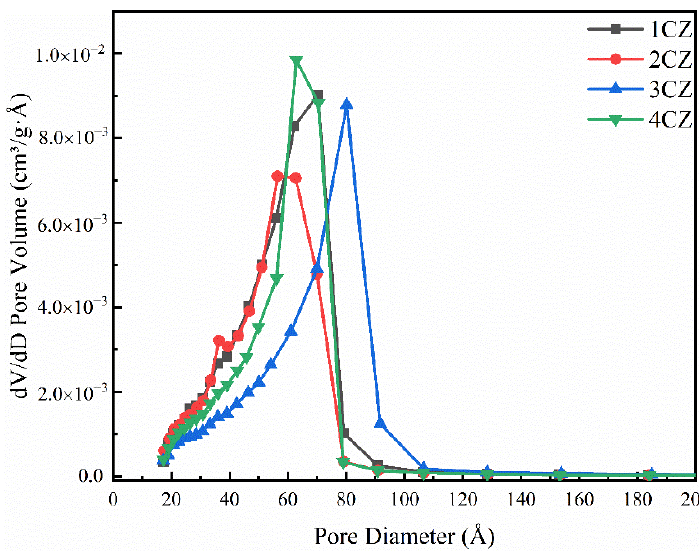
Figure 10. BJH Desorption dV/dD Pore Volume Distribution for the CZ